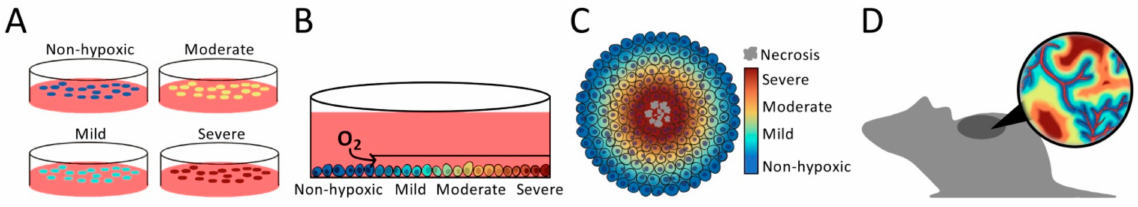
Figure 2. Model systems for studying hypoxia levels. ( A ) 2-dimensional (2D) monolayer cell cultures. Exposed to specific oxygen concentrations in a gas chamber. ( B ) 2D monolayer cell culture with an oxygen gradient created by a plate inserted into the petri dish at one end of the culture to limit oxygen and nutrient exchange with media. ( C ) Spheroid with a gradient in hypoxia levels from the periphery (non-hypoxic) towards the center (necrosis). ( D ) Animal model, showing a mouse with tumor grown on the back. The distribution of hypoxia levels in a section through the tumor is indicated. ( A – D ) hypoxia levels are indicated by the color code, with approximate oxygen concentrations (% O 2 ) and tensions (mmHg) provided by the x -axis in Figure